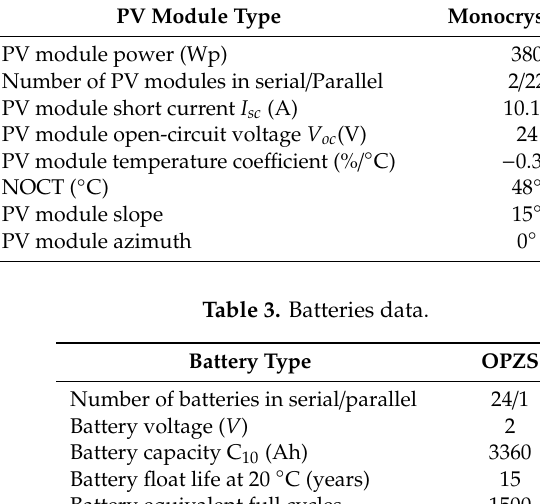
Figure 4. Typical daily load profile for the case study at the grid location.